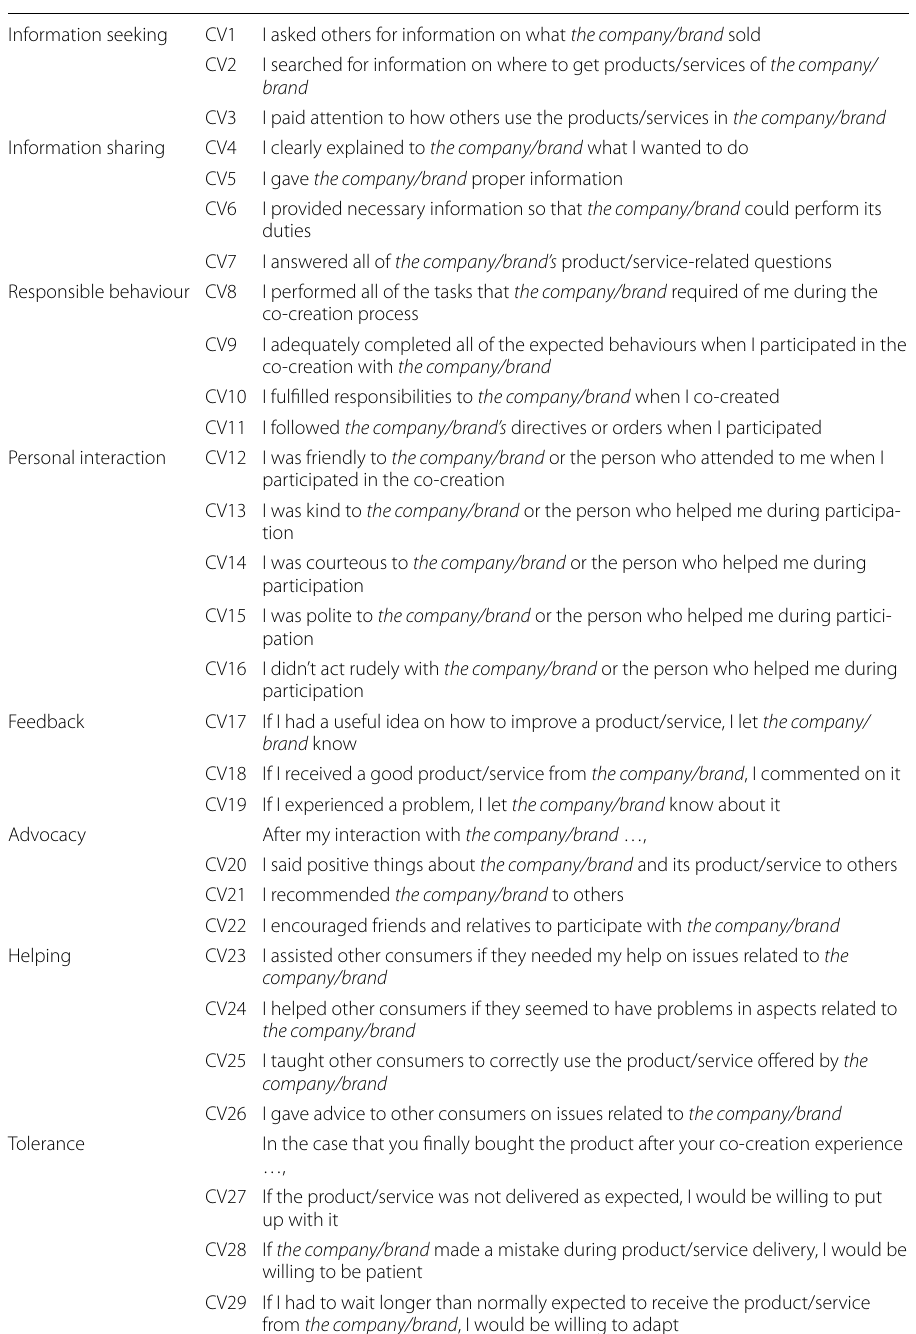
Table 1 Co‑creation value